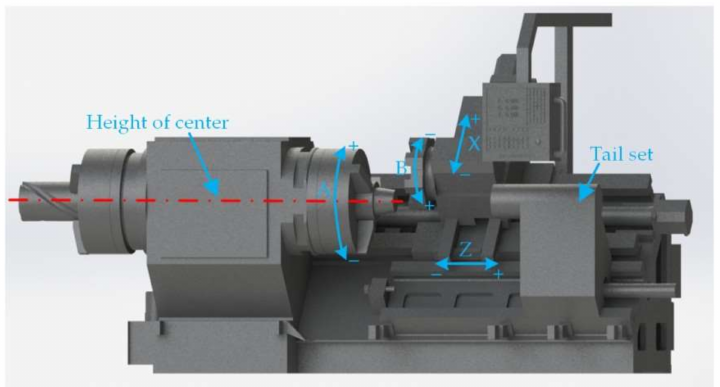
Figure 1. Motions of a typical four-axis machine